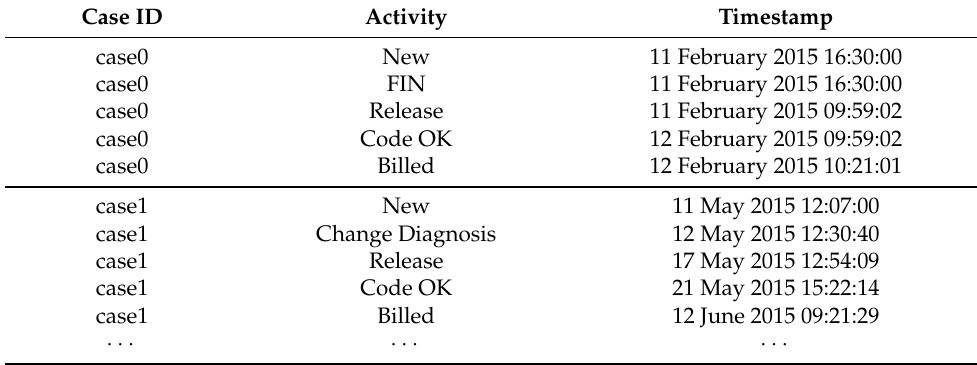
Table 1. An example event